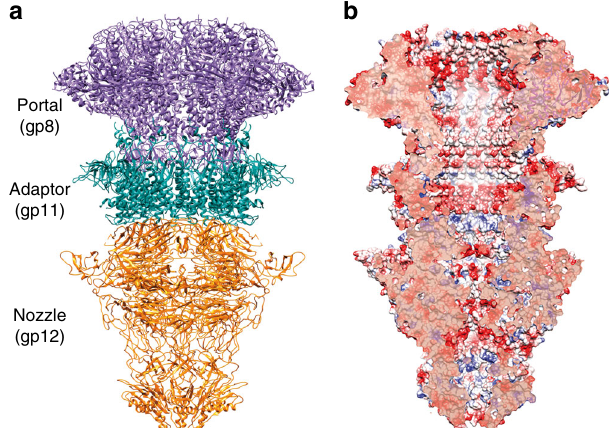
Fig. 2 Structure of the T7 tail. a Ribbon representation of the cryo-EM T7 tail structure (gp8-gp11-gp12). Gp8 portal, gp11 adaptor, and gp12 nozzle proteins are shown in purple, green, and orange,